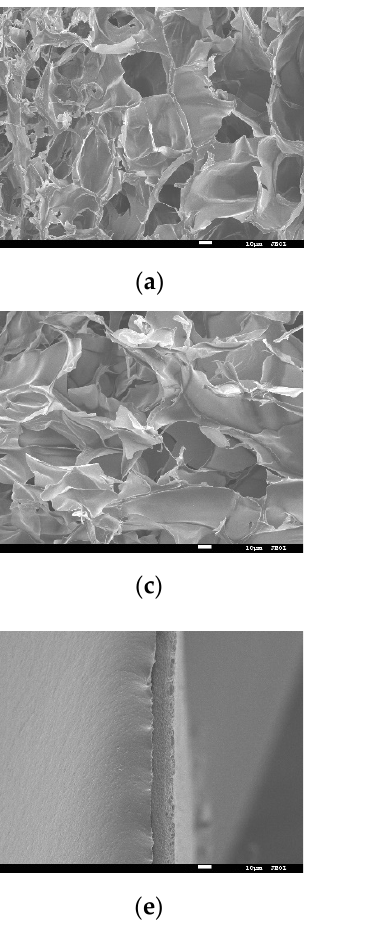
Figure 2. Representative scanning electron microscope (SEM) images of U. pinnatifida under different cooking methods (10 µm length scale bar): ( a ) raw (× 500); ( b ) blanching (× 500); ( c ) steaming (× 500); ( d ) boiling (× 500); ( e ) baking (× 500); ( f ) baking (× 2000).